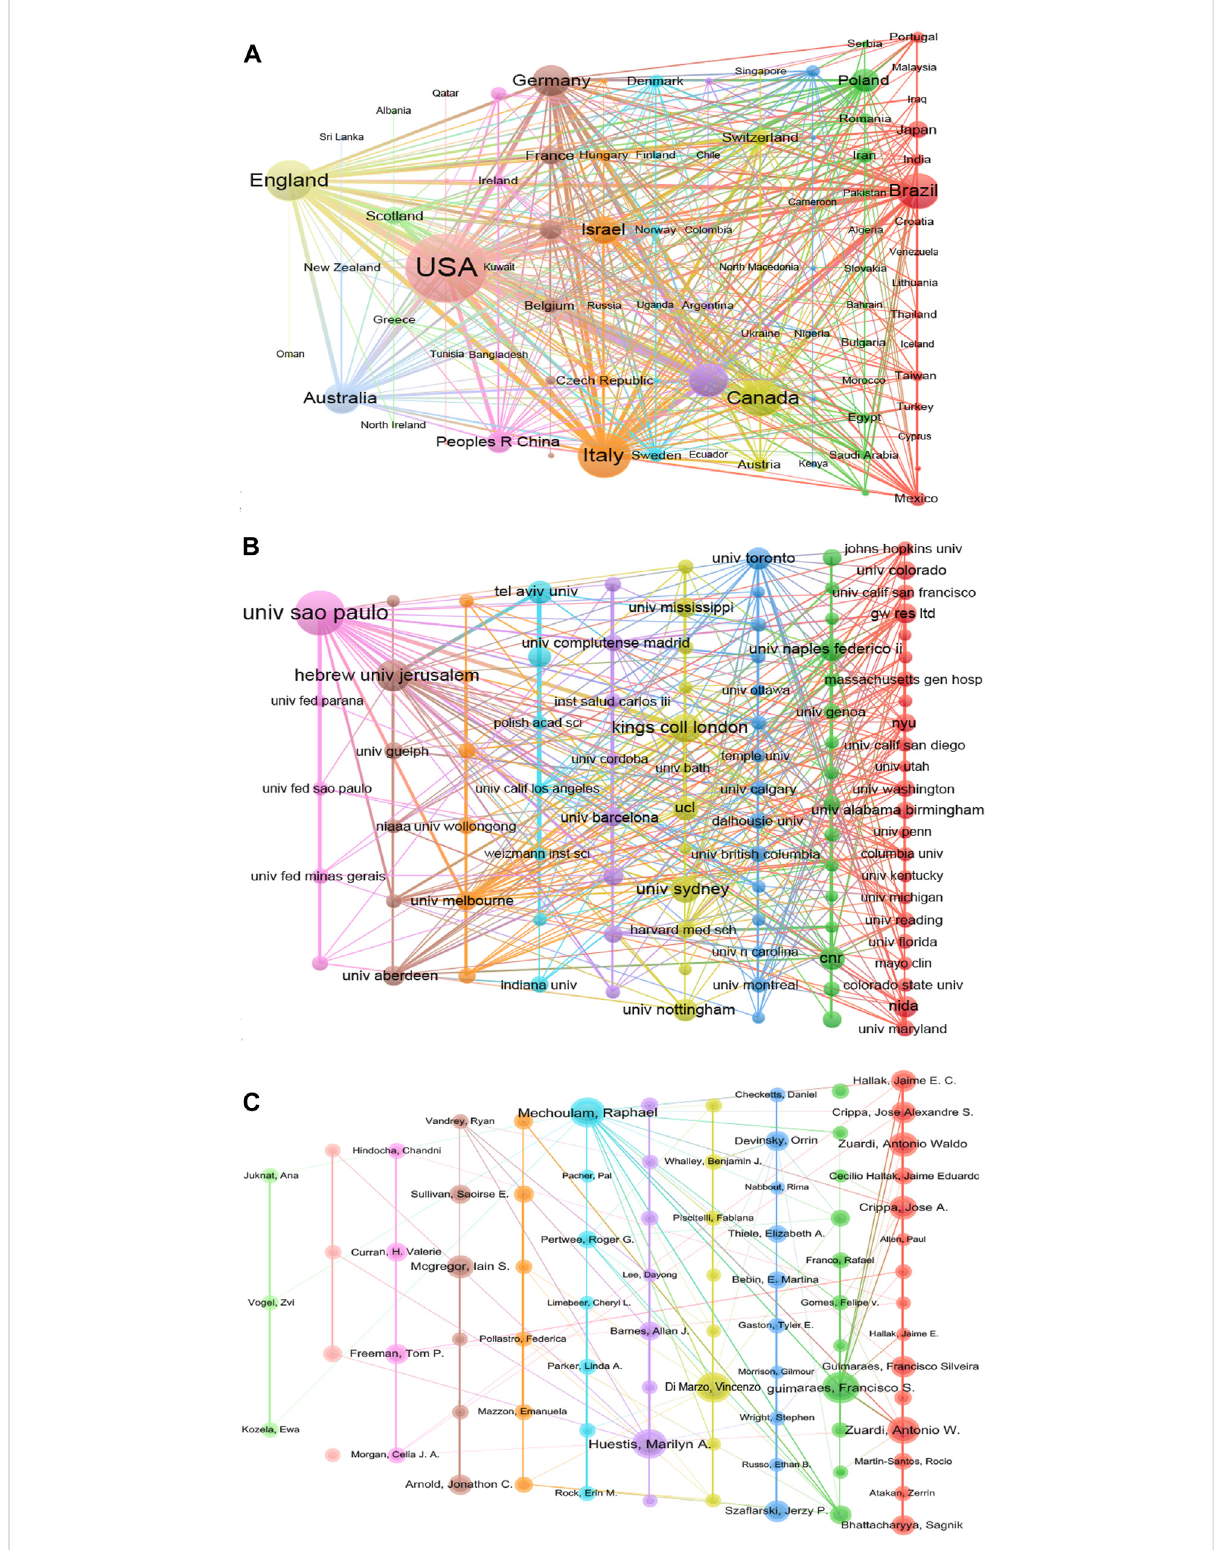
FIGURE 4 Co-authorships analyses. (A) Co-authorships between different countries. (B) Co-authorships between different institutions. (C) Co- authorships between different